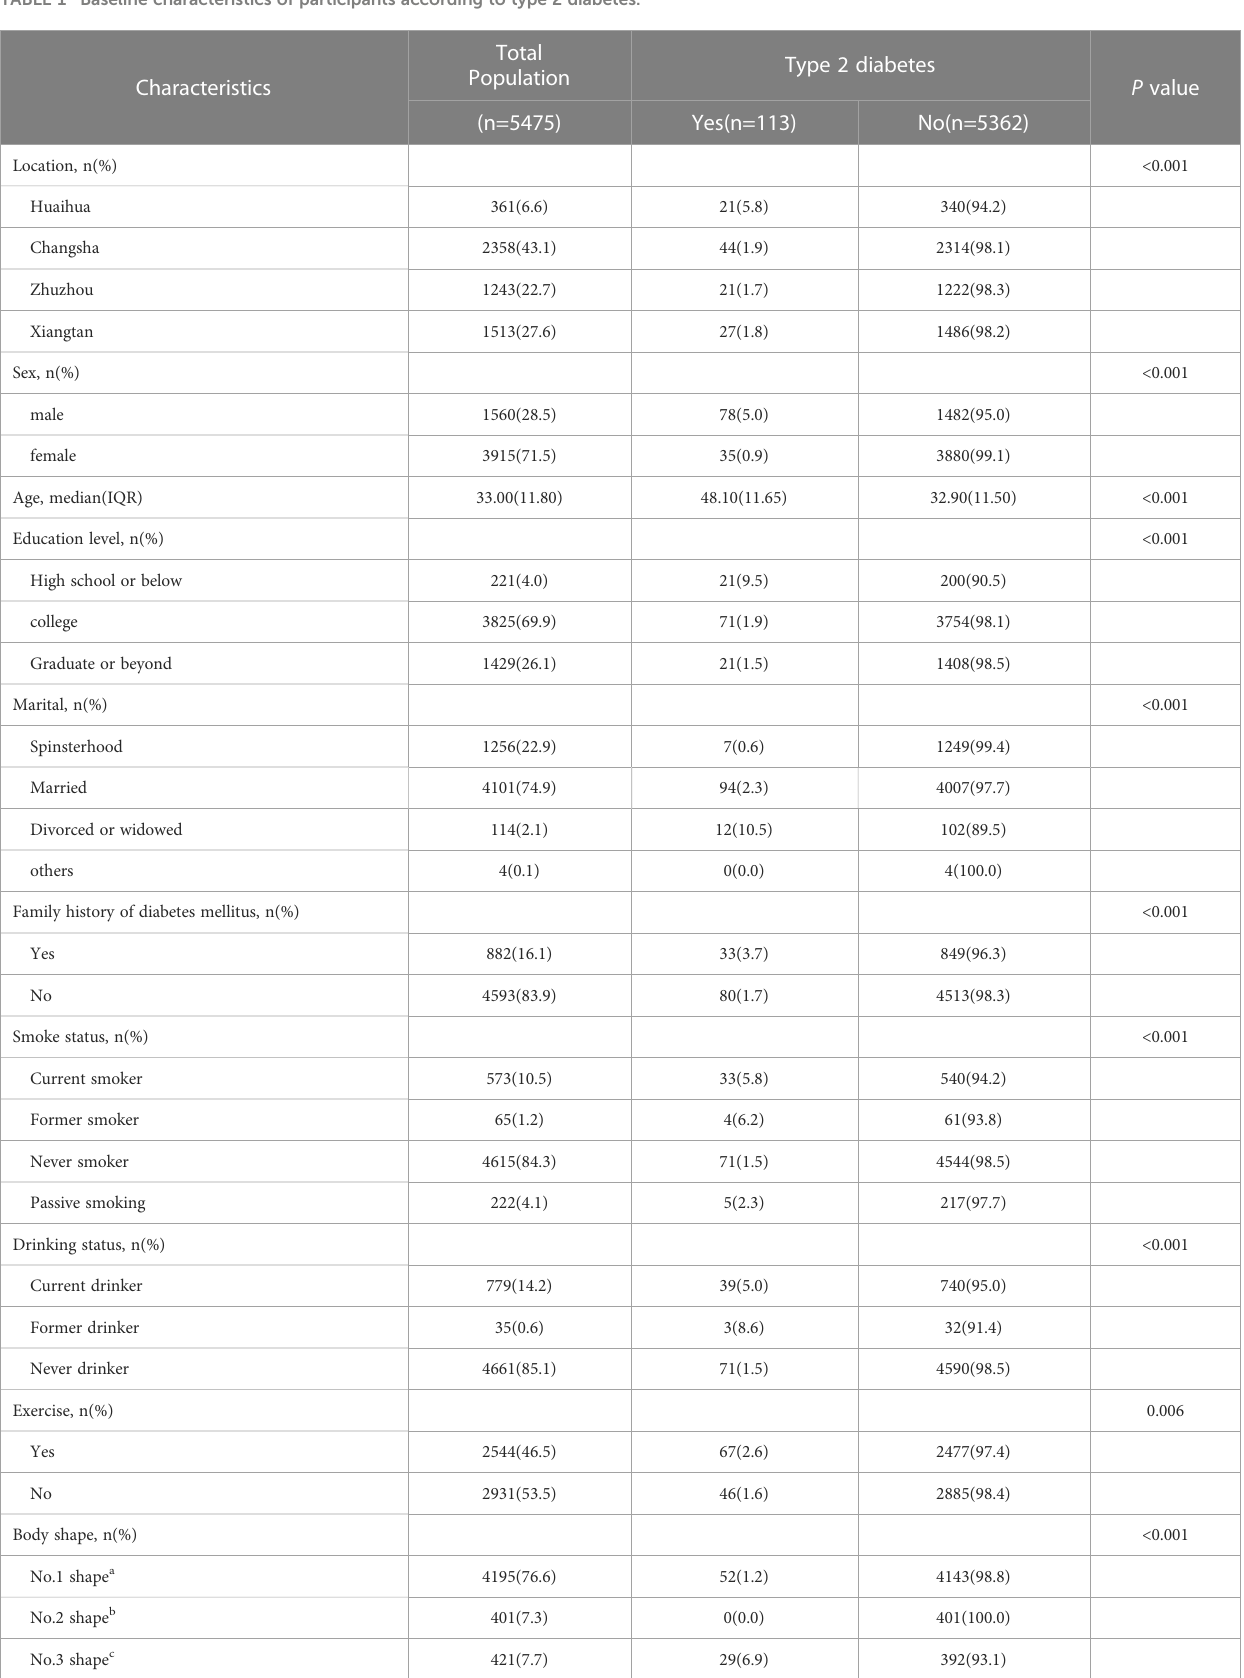
TABLE 1 Baseline characteristics of participants according to type 2